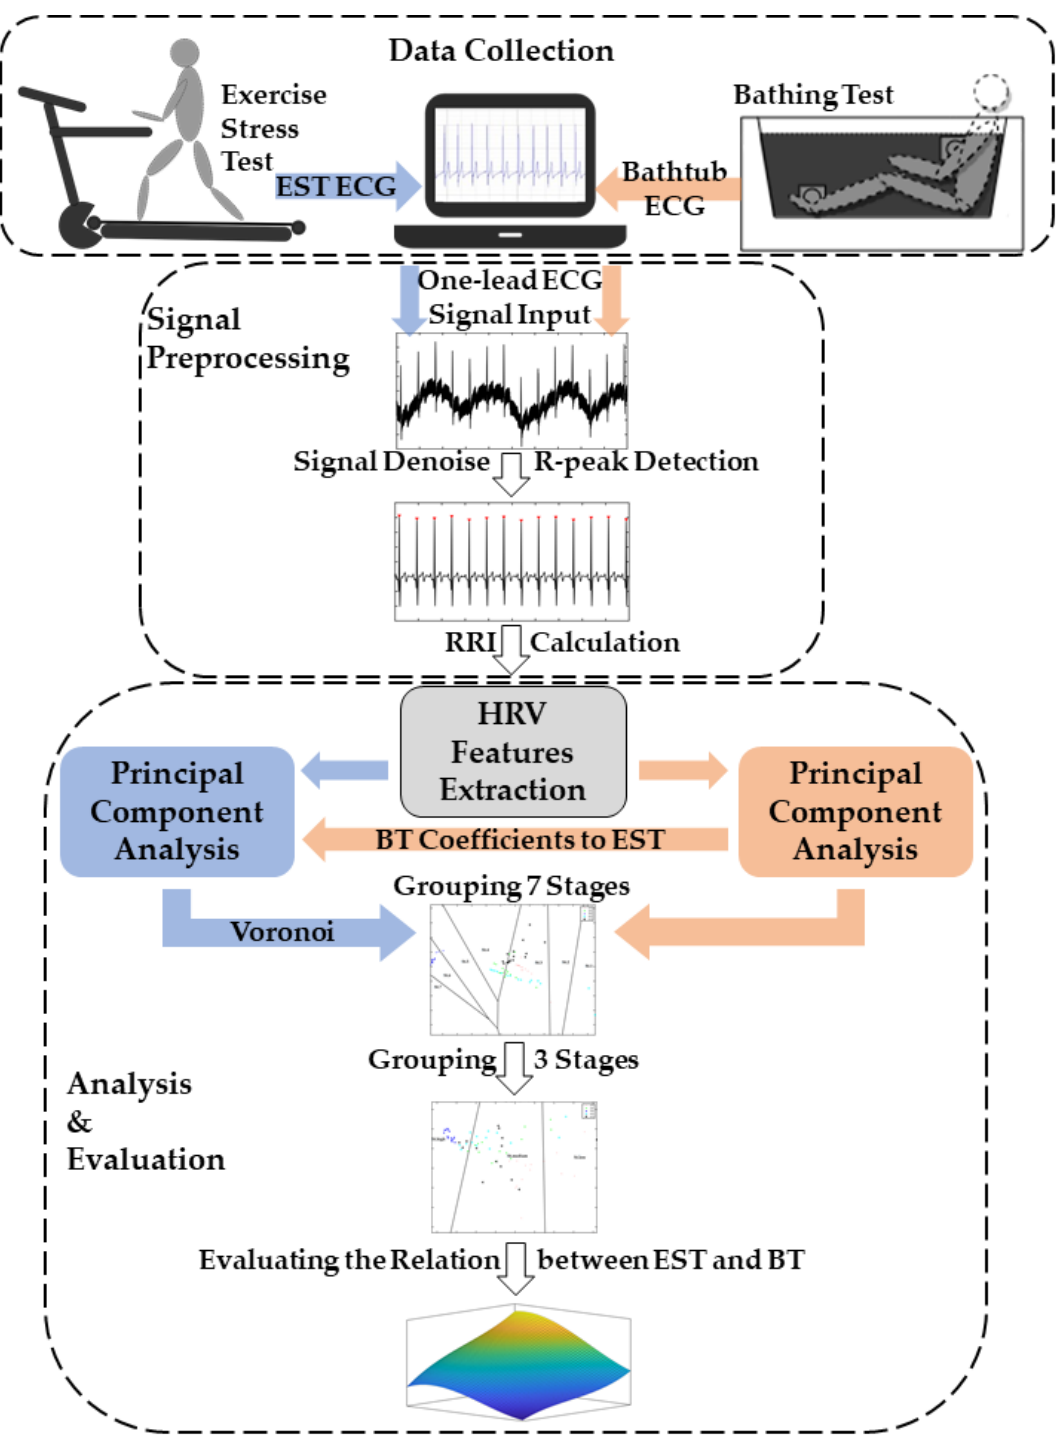
Figure 1. Scheme of the implementation procedure of this study. Blue arrows represent the EST. Pink arrows represent the BT.